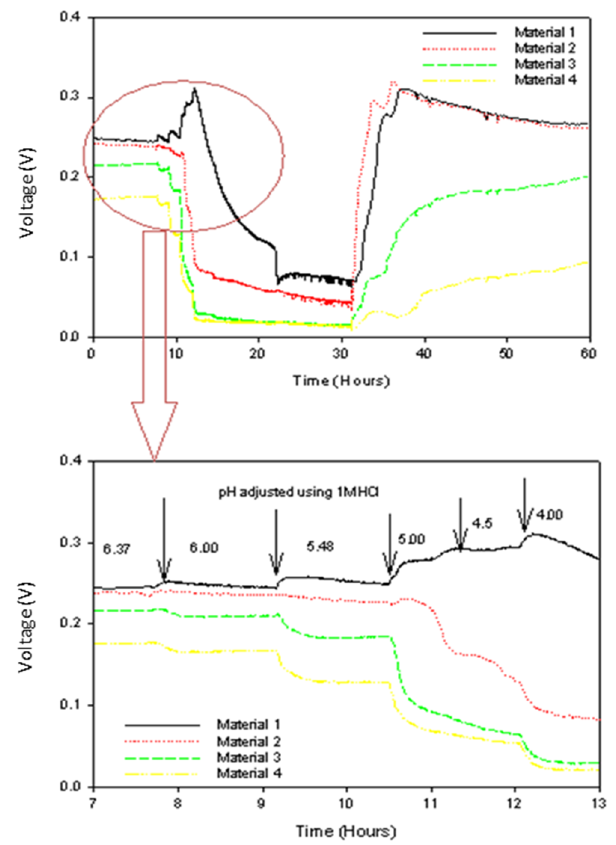
Figure 8. The e ff ect of pH shifts on biofilms formed on materials 1, 2, 3 and Figure 8. The effect of pH shifts on biofilms formed on materials 1, 2, 3 and 4.